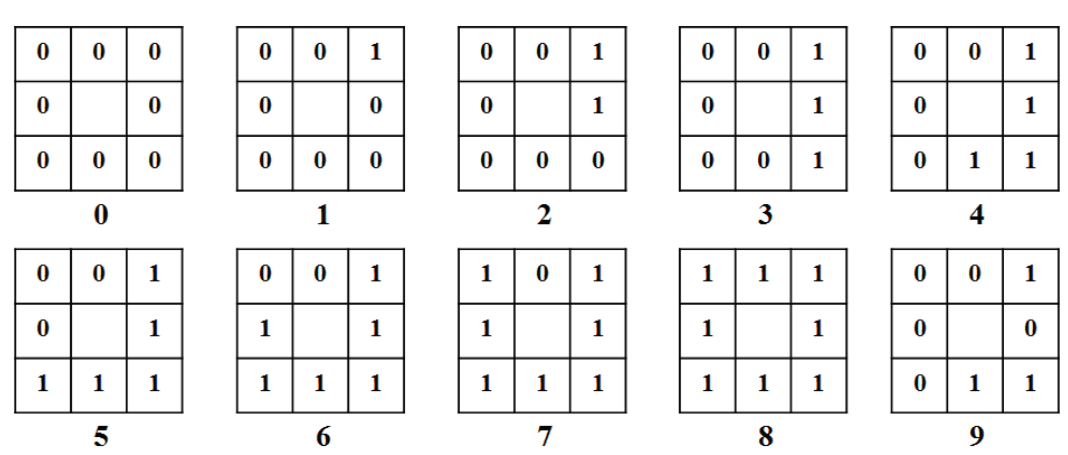
Figure 12. Examples of LBP codes for uniform patterns (0 to 8) and a non-uniform pattern (9) when P = 8, R = 1 from Figure 11.